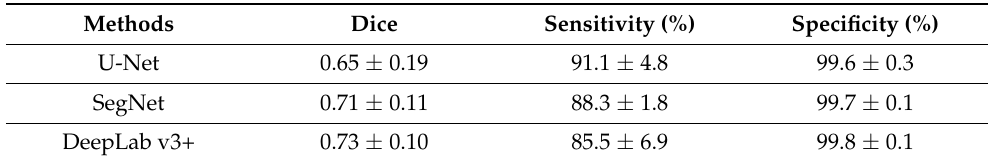
Figure 7. Segmentation results of microvessel according to different semantic segmentation models. Panels are as follows: ( A ) manual annotation, ( B ) results obtained using U-Net, ( C ) results obtained using SegNet, and ( D ) results obtained using DeepLab v3 plus. In ( C ), the SegNet had similar results as compared with DeepLab v3 plus; however, there were some misdetections. The U-Net ( B ) had the worst detection results among all deep learning models. The red is a microvessel. Table 3. Mean performance metrics of microvessel segmentation according to different semantic seg- mentation networks (U-Net, SegNet, and DeepLab v3 plus), including the Dice coefficient, sensitivity, and specificity. The DeepLab v3 plus model showed the highest Dice coefficient. All metrics were obtained after candidate classification.